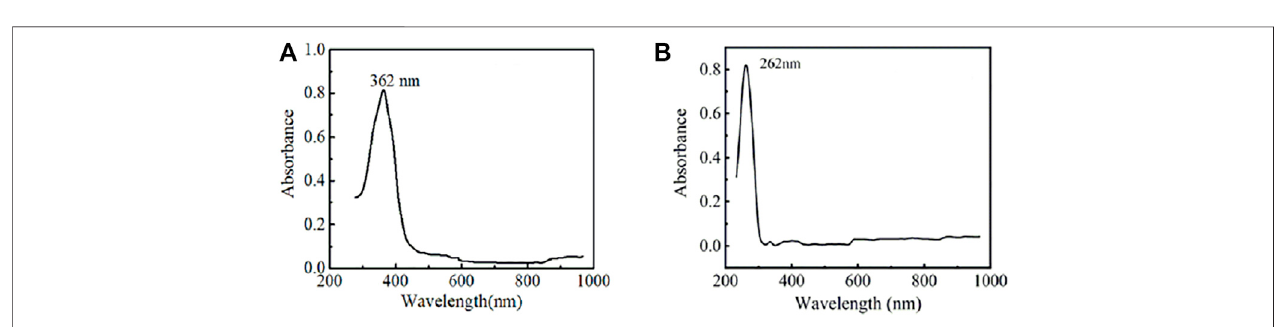
(cid:129) 2PF 6 − (B) .